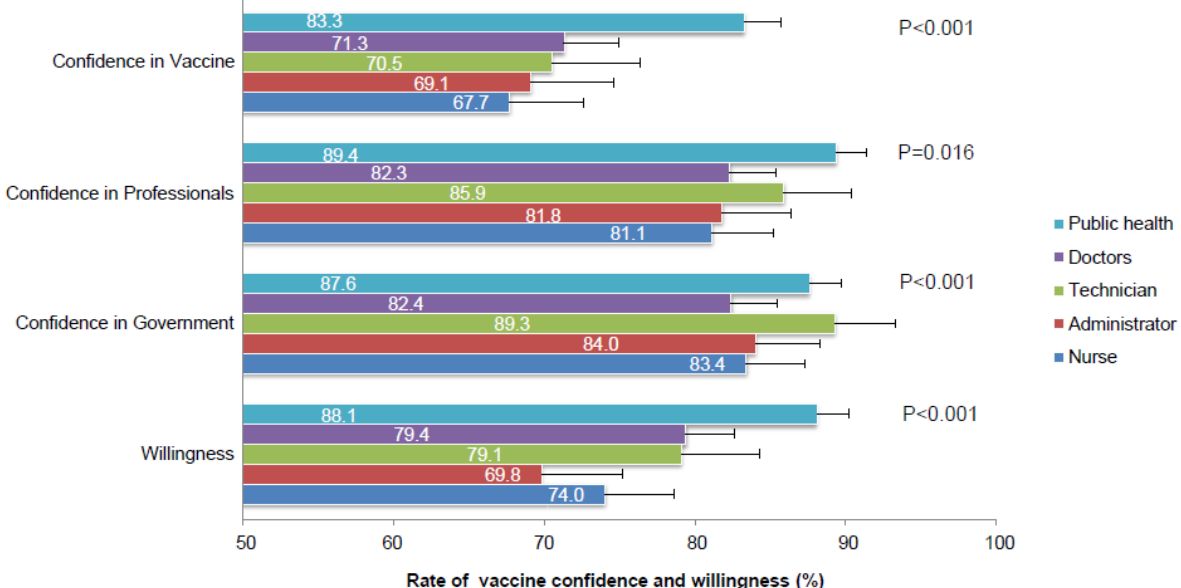
Figure 2. The rates of vaccine confidence and willingness among different HCWs.